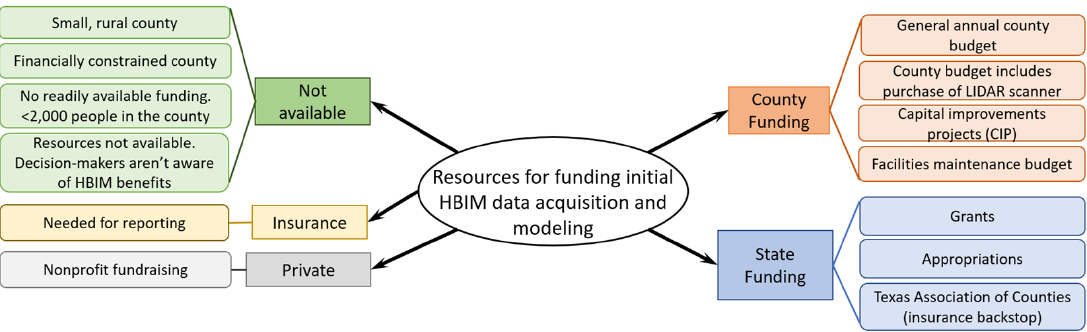
Figure 17. Results to interview question #7: resources for implementation of an HBIM program. Question 8: What resources do you have to support continued upkeep of a HBIM repository?